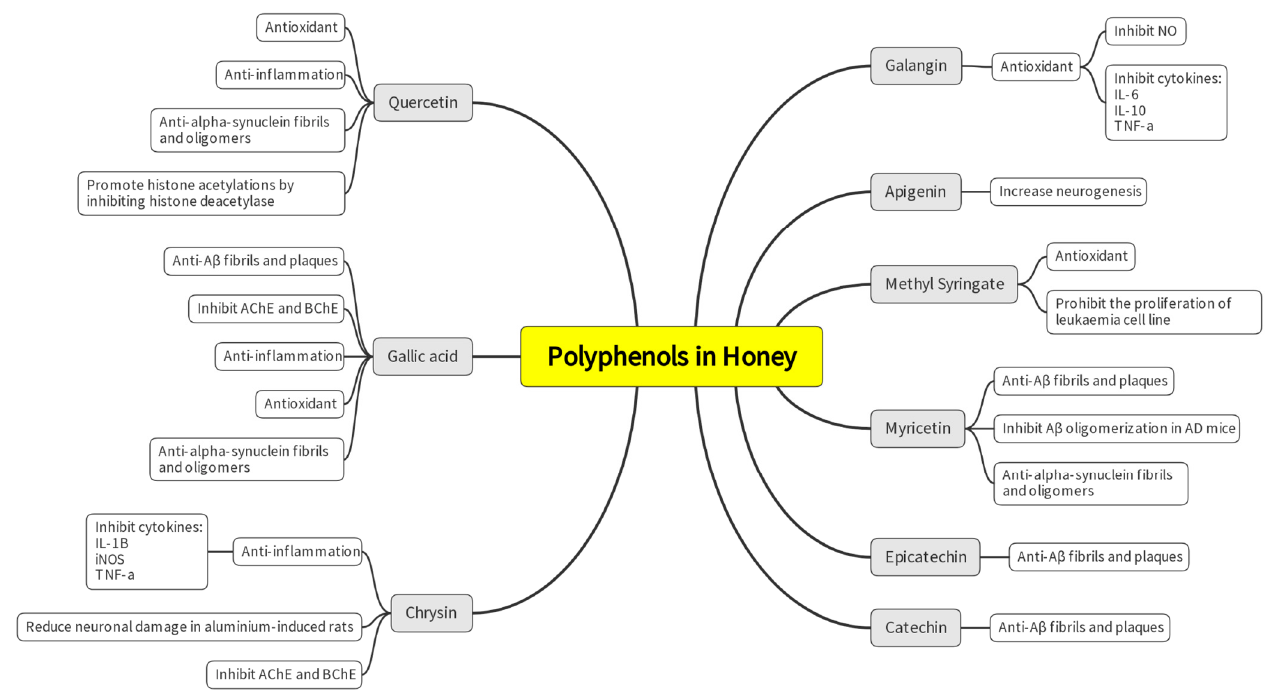
Figure 4. Highlighted polyphenols in honey and their potential for neuroprotection.